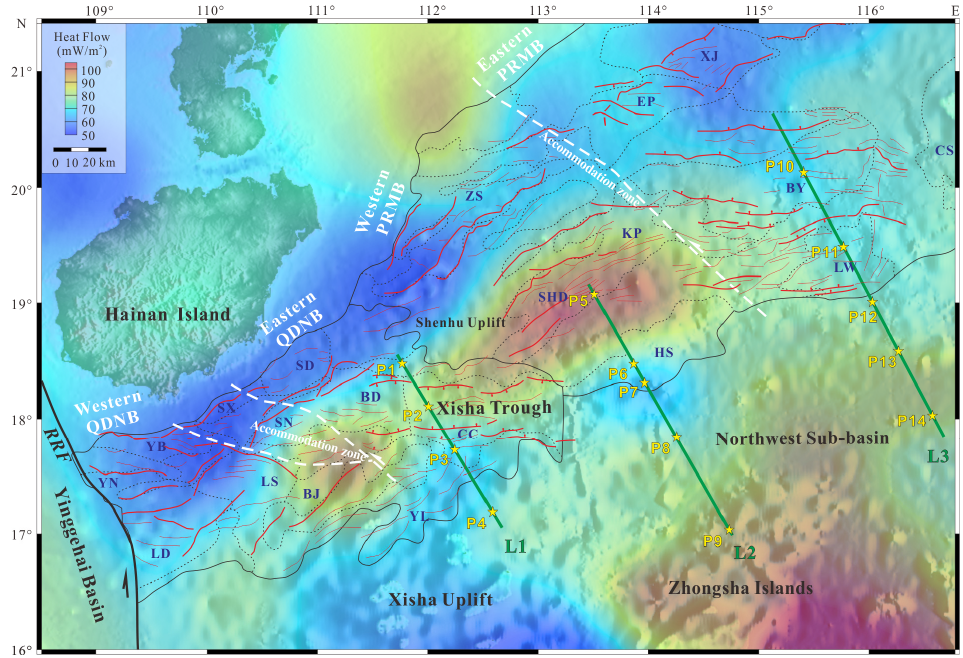
Figure 2. The distribution of surface heat flow in the northwestern SCS, the heat flow date is from Mi et al. [67], Zhang and Wang [33], Li et al. [68], Wang et al. [69], and Shi et al. [34]. The green solid lines (L1, L2, and L3) denote the locations of multi ‐ channel seismic reflection profiles, which were used to examine the thermo ‐ rheological structures [14,25,26]. Yellow stars of P1 ‐ P14 show the loca ‐ tions of calculated typical lithospheric rheological structures.